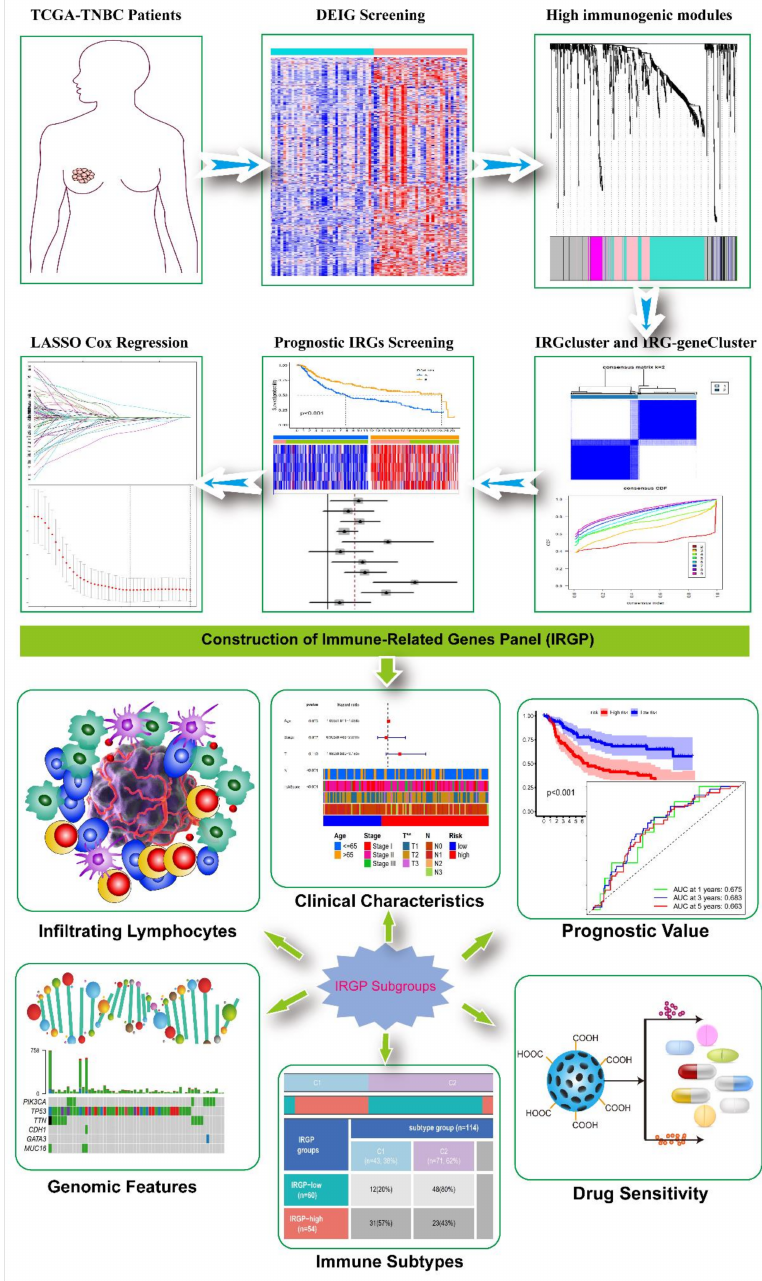
Figure 1. The flowchart of study design of current